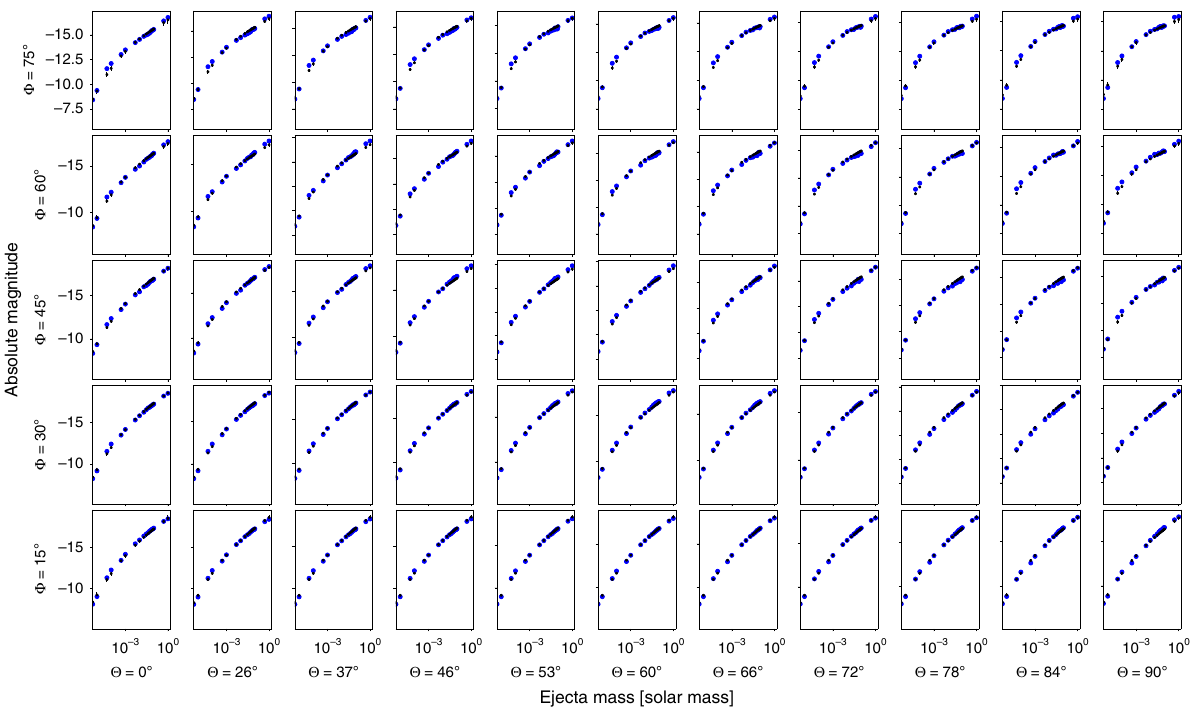
Fig. 4 Fit of Eq. (3) for the models in ref. 25 . We vary the opening and viewing angles of the employed simulation set in r -band. The black points are the fi ts (with the measured error bar from the Chi-squared) while the blue points are computed directly from the models in ref. 25